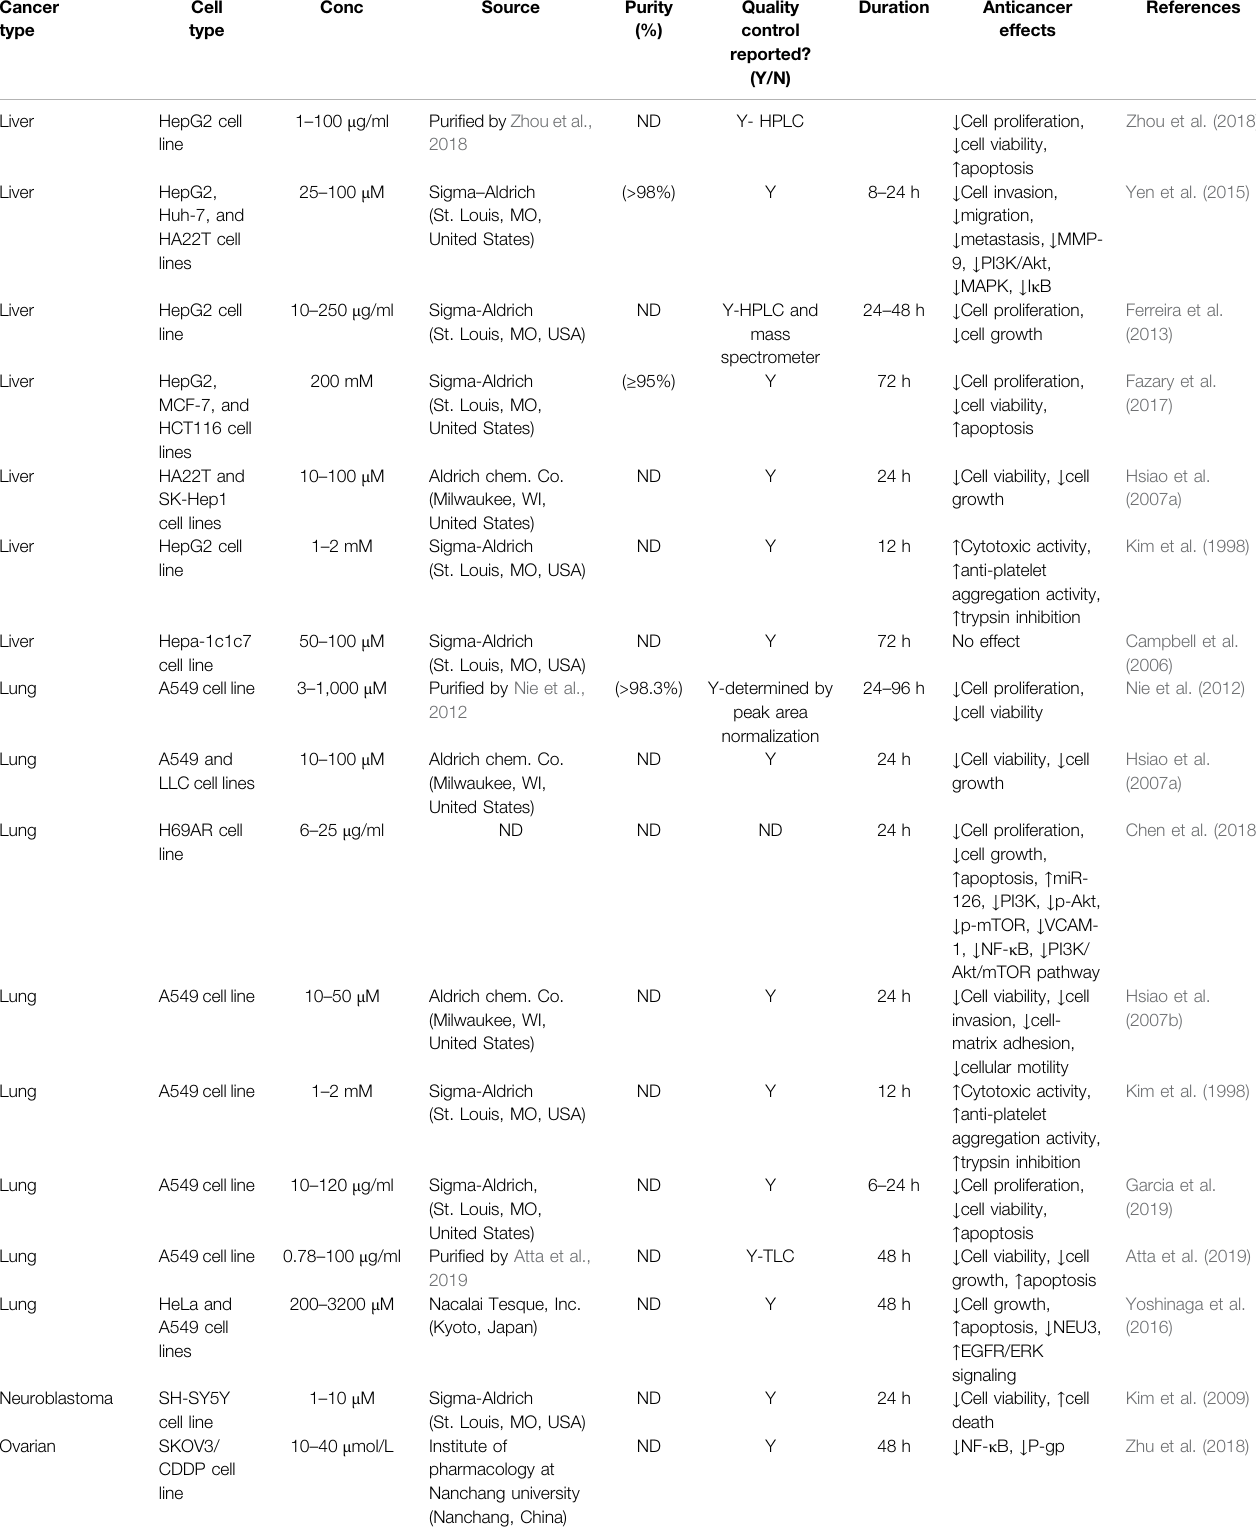
TABLE 3 | ( Continued ) Potential anticancer effects and related mechanisms of action of naringin based on in vitro